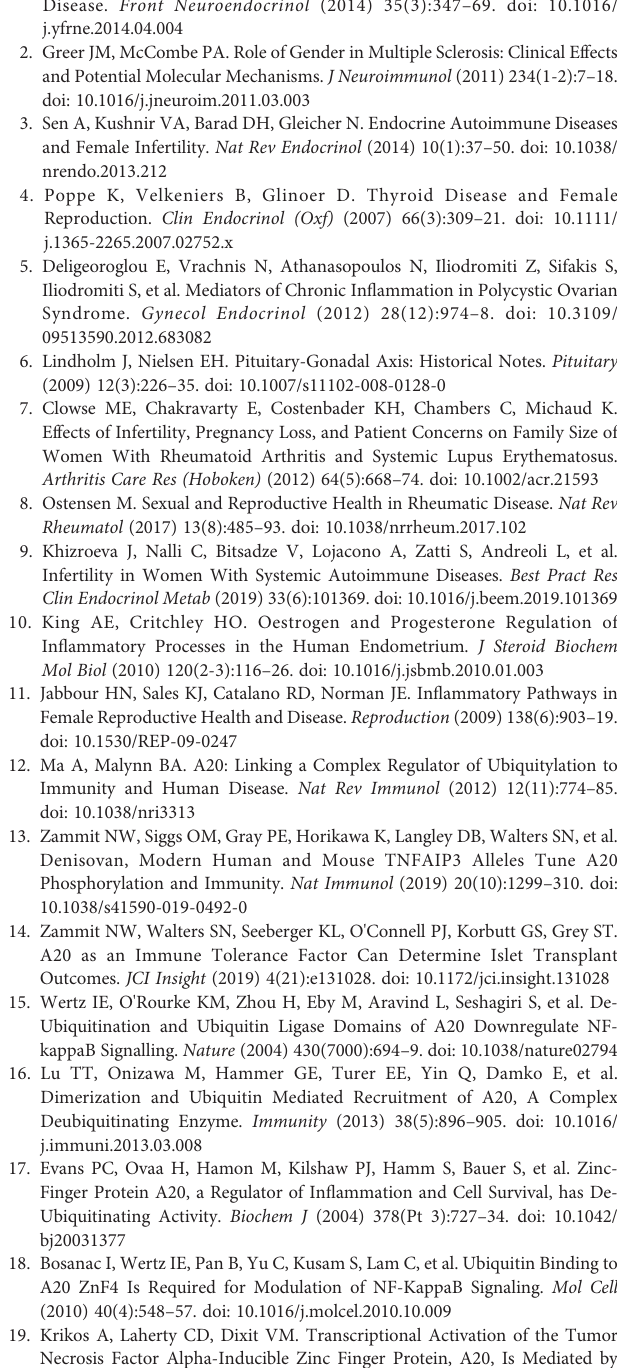
Supplementary Table 1 | Ovarian cycling was assessed from 5-8 weeks of age and monitored weekly. Note the homozygous I325N mice did not cycle in early stages, then ultimately became pregnant but also with a delay i.e. time to pregnancy for I325N mice = 38.7 days versus 22.8 days for wild type